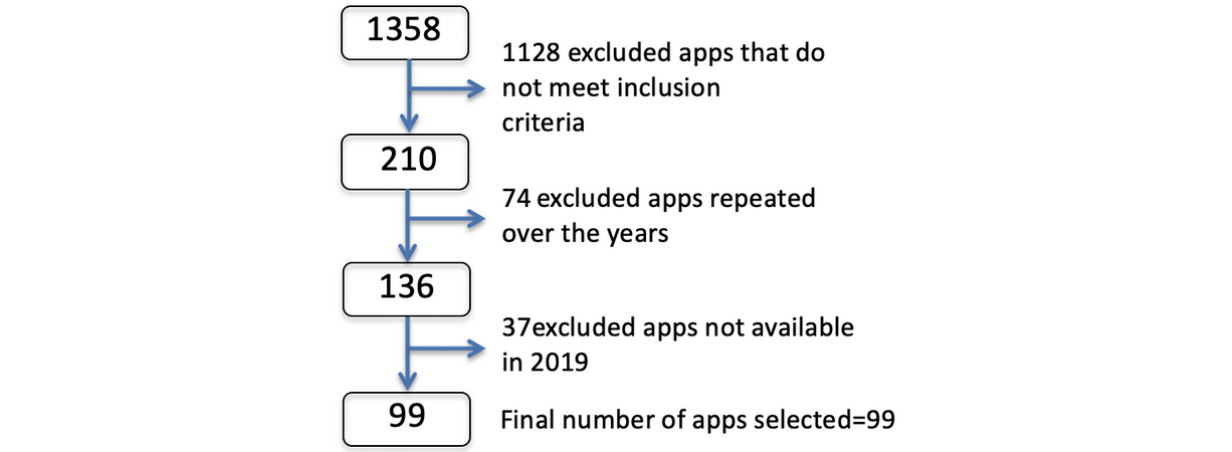
Figure 1. Flowchart of the selection of